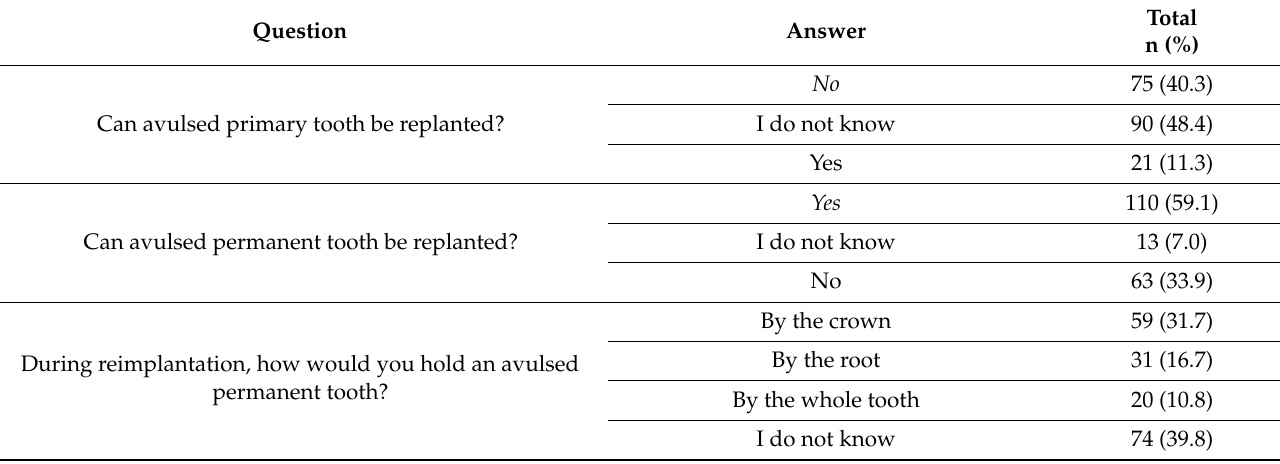
Table 2. The frequency distribution (%) of pediatricians’ answers about emergency management of dental trauma injuries.